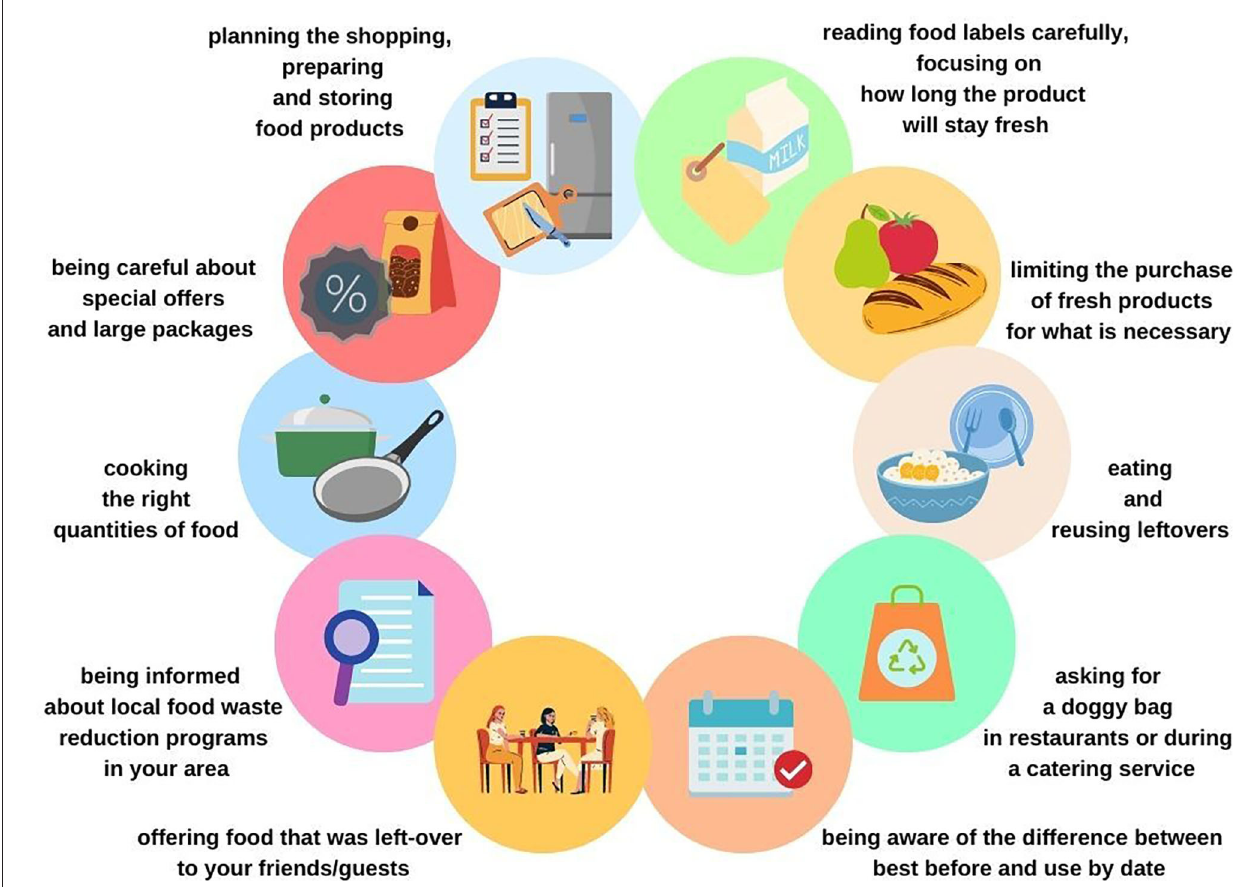
FIGURE 1 | The 10 recommendations made by the OERSA to prevent food waste by